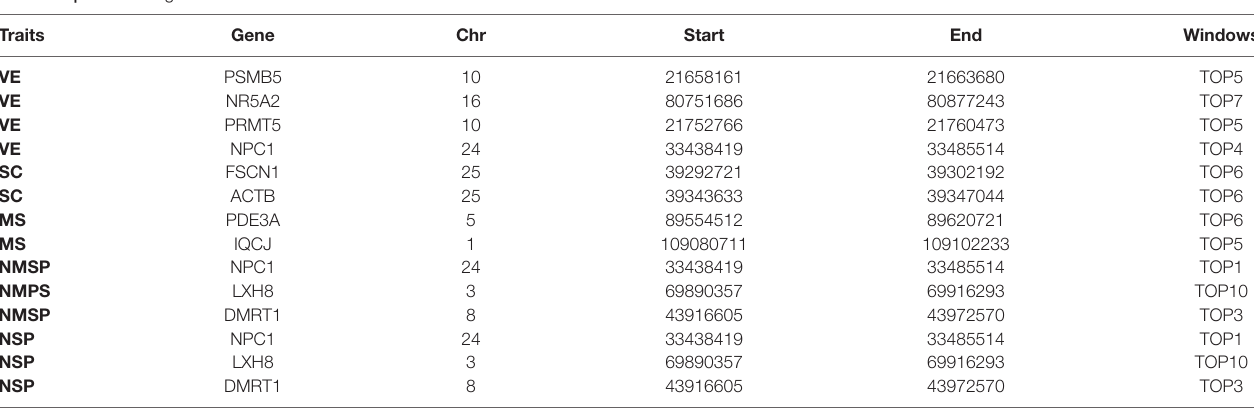
TABle 3 | Candidate genes for five semen traits. Traits Gene Chr Start end Windows